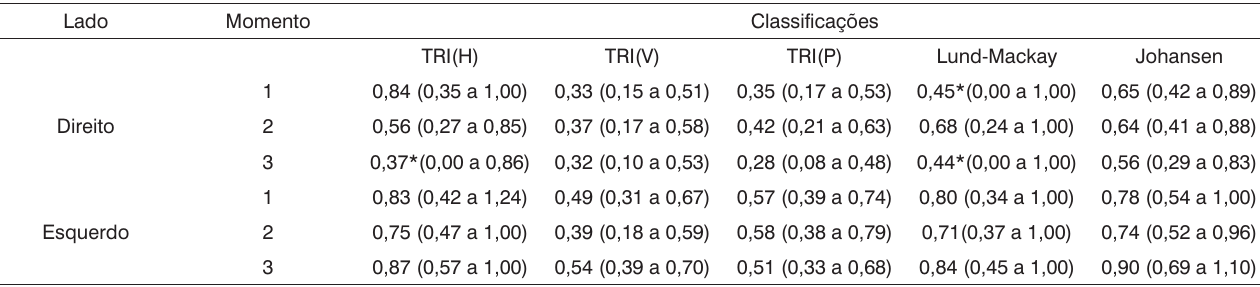
Tabela 2. Coeficiente Kappa para a concordância entre os examinadores. Lado